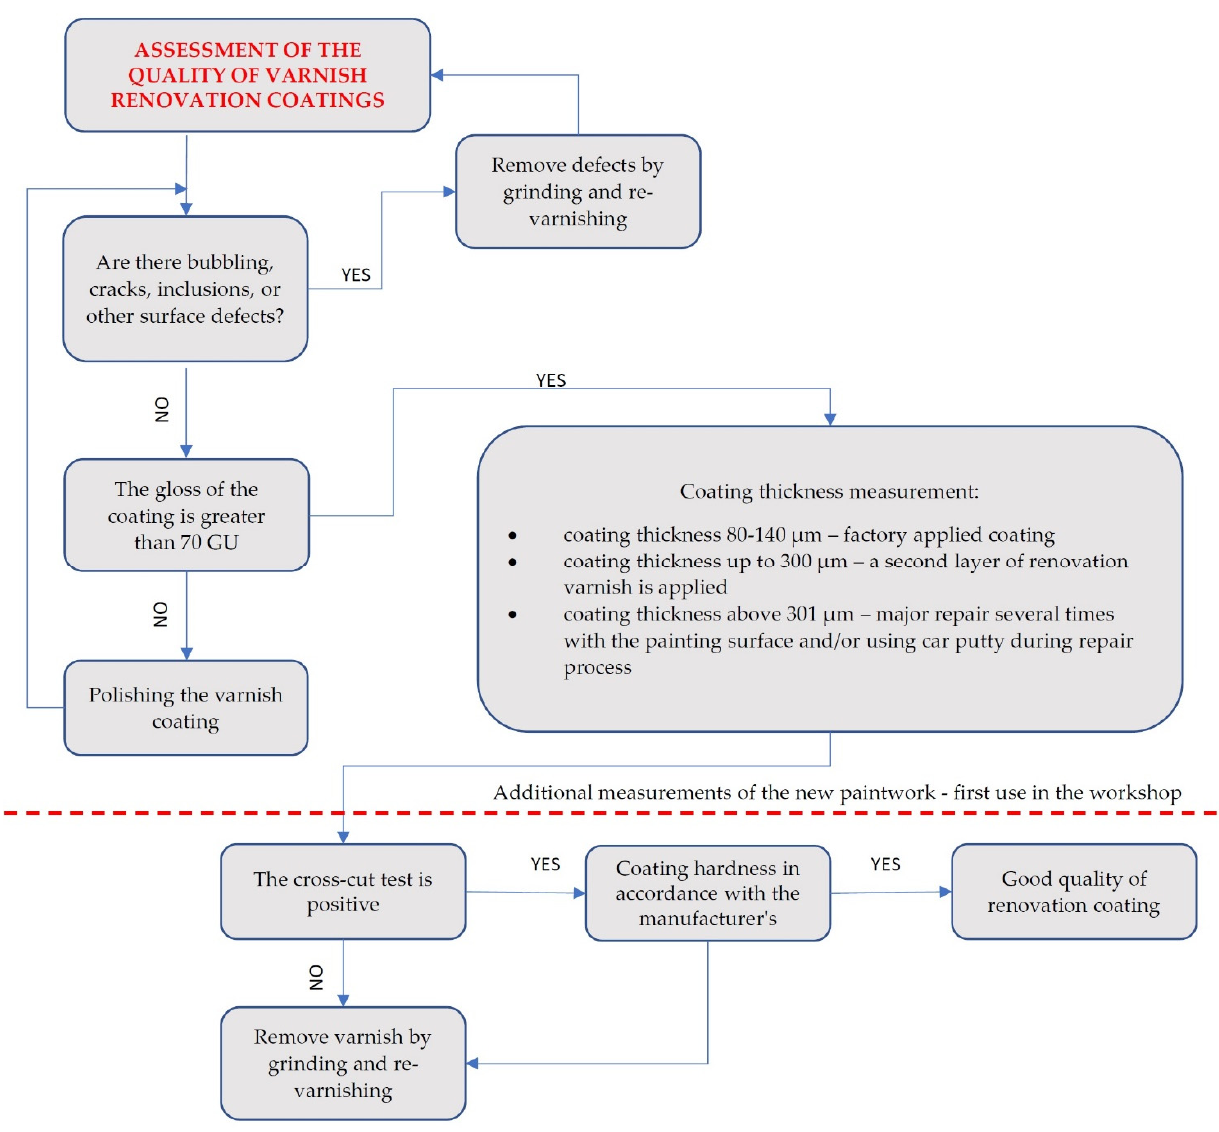
Figure 11. Algorithm for the quality assessment of renovation varnish coatings.